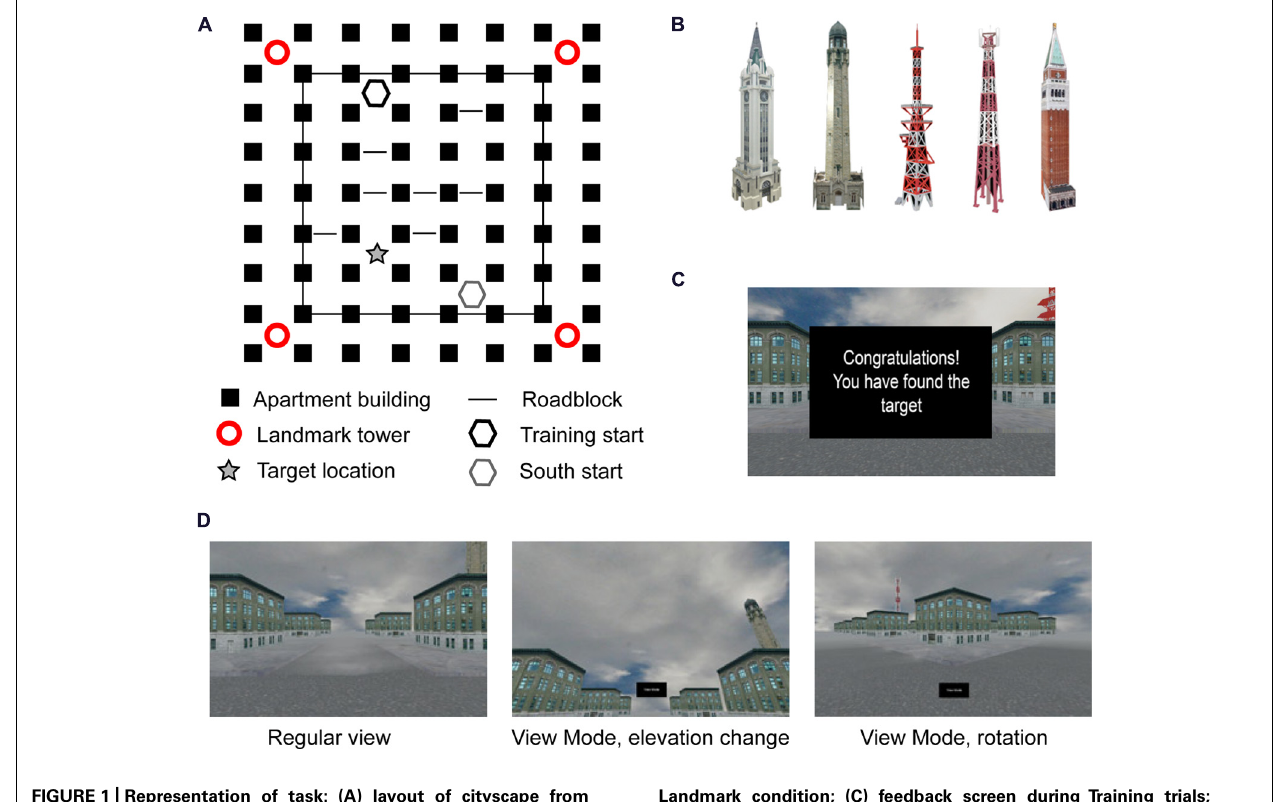
Landmark condition; (C) feedback screen during Training trials; (D) examples of screen during regular navigation and “view mode” changes at an